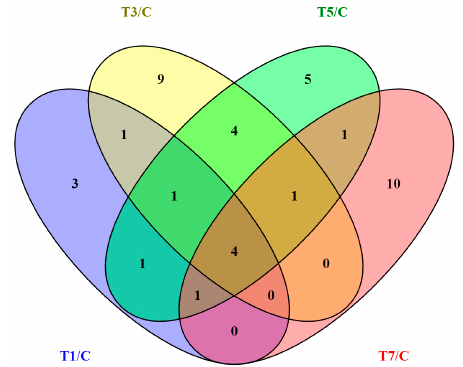
Figure 4. Venn diagram of differentially expressed circRNAs. Differentially expressed circRNAs at 1, 3, 5, and 7 dpi were included in the Venn diagram, and four circRNAs are clearly differentially expressed at all four time points. Table 2. Number of differentially expressed circRNAs following grass carp reovirus (GCRV) infection.